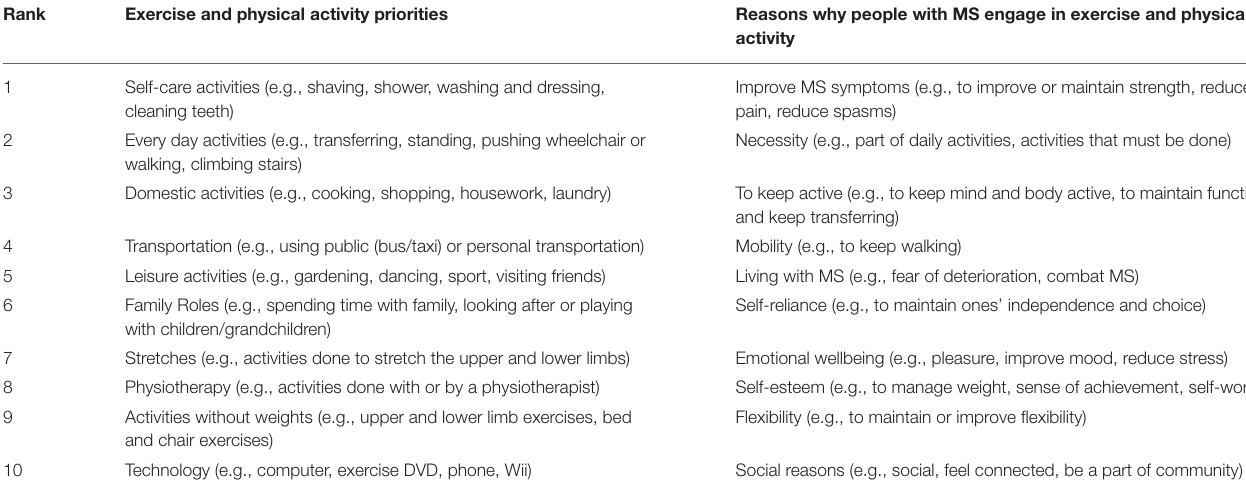
TABLE 1 | Prioritised exercise and physical activity and reasons why people with MS engage in exercise and physical activity.